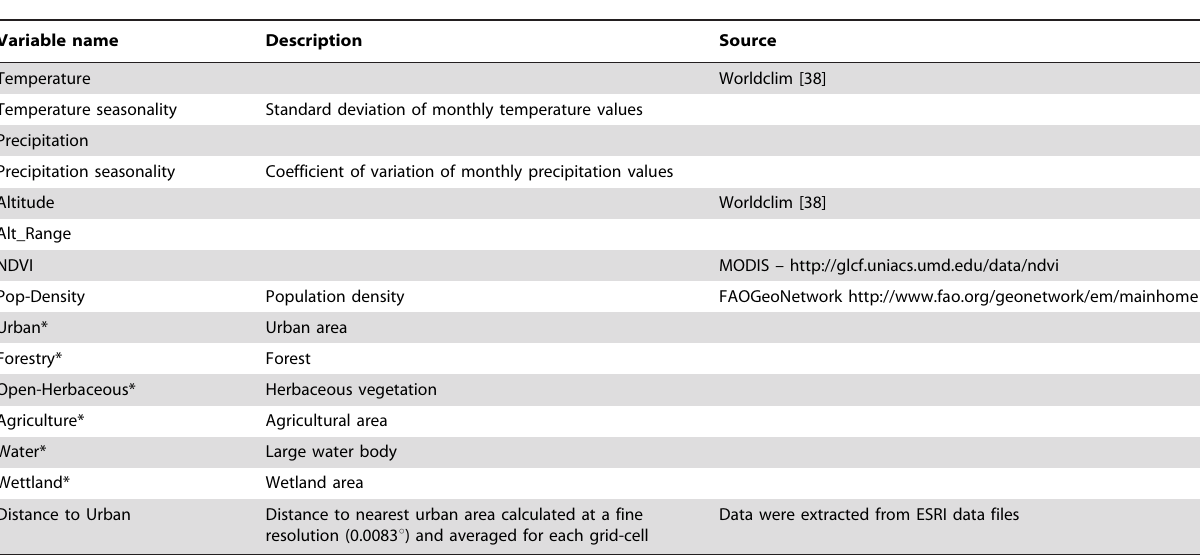
Table 1. Environmental variables used in the analyses, and their